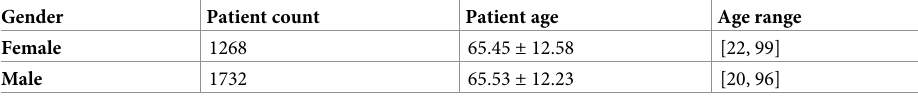
Table 2. Patient statistics of the dataset of 3,000 initially selected